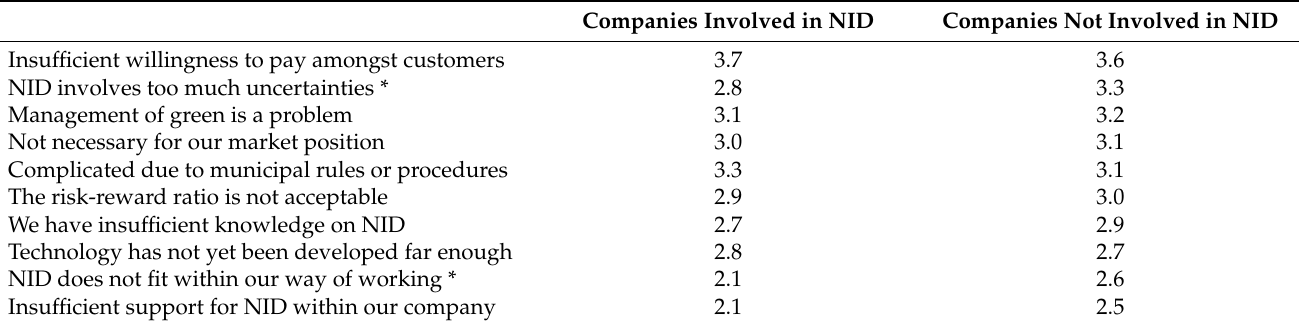
Table 4. Main barriers for engaging in NID on a 1–5 Likert scale ( n =